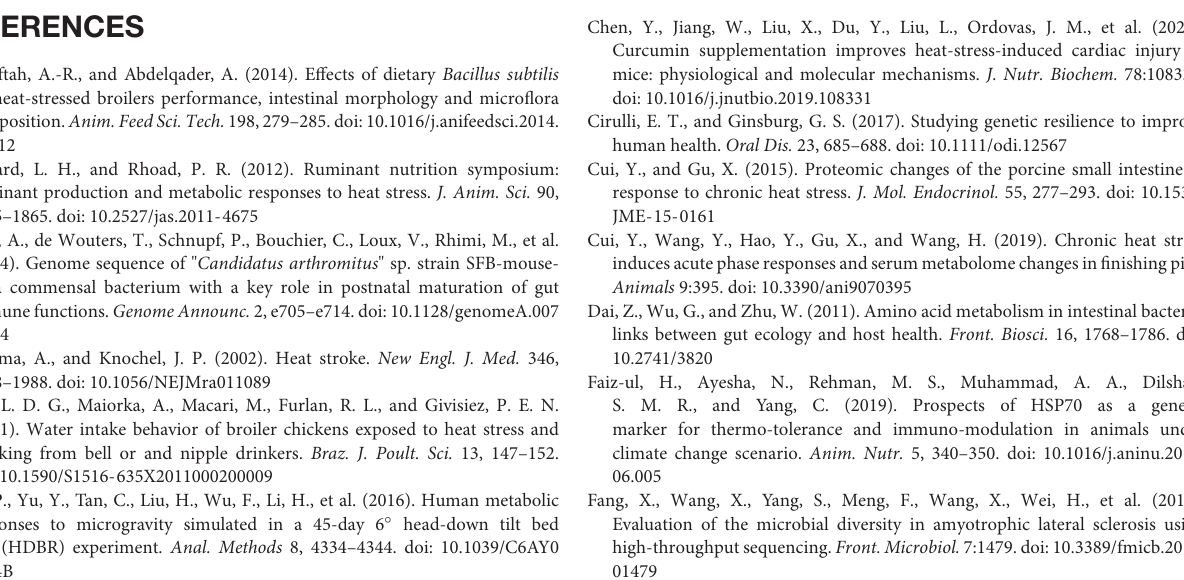
Supplementary Figure 1 | Effect of heat stress on cecal microbiota of mice. (A) Welch’s t -test bar plot at the family level (relative abundance > 1%). (B) Welch’s t -test bar plot at the genus level (relative abundance > 1%). (C) Welch’s t -test bar plot at the OTU level (relative abundance > 1%). (D) Relative abundance of microbiome at the class level. (E) Relative abundance of microbiome at the order level. (F) Relative abundance of microbiome at the genus level. (G) The ratio of Firmicutes/Bacteroidetes. CON=control group; HS=heat stress group. Supplementary Figure 2 | The heatmap of KEGG pathway level 2. CON=control group; HS=heat stress group. Supplementary Figure 3 | Biomarker analysis of metabolites based on the random forests algorithm. ROC view (A) , probability view (B) , and cross validation (C) of three selected metabolites, namely carbazole, purine nucleoside and stearic acid. CON=control group; HS=heat stress group. Supplementary Table 1 | The influence of HS on α -diversity of gut microbiota. Supplementary Table 2 | The normalized microbiome data. Supplementary Table 3 | Significantly different metabolites in cecal contents between CON and HS groups. Supplementary Table 4 | The normalized metabolomics